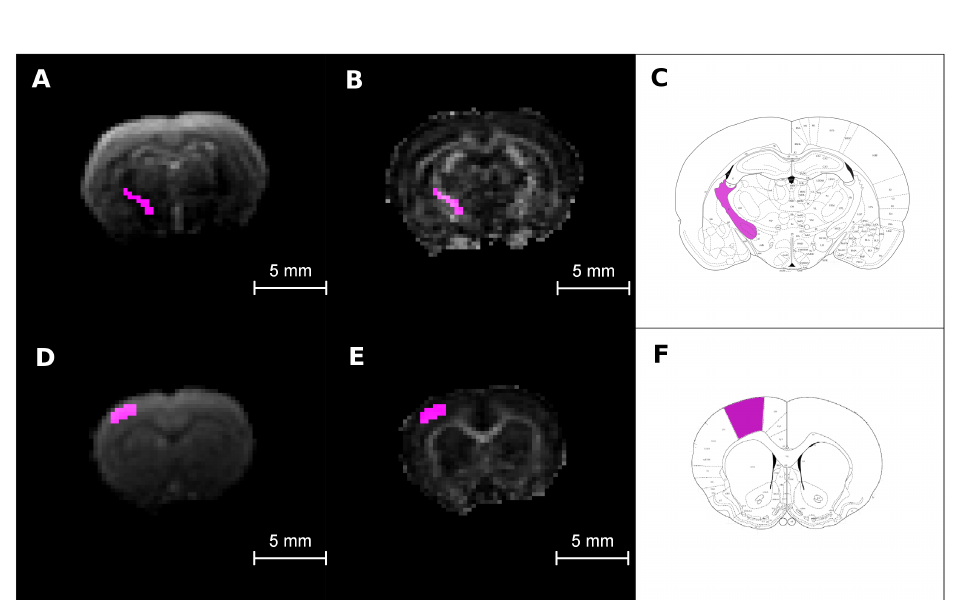
Figure 4: Regions of interest for CNR measurements and tractography generation. Columns from left to right: Region of interest in the DWI, in the FA image and in a rat atlas. Upper row (A-C): the bundle of white matter pixels correspond to the internal capsule (CI). Bottom row (D-F): primary motor cortex (Cx). Atlas figures were adapted from